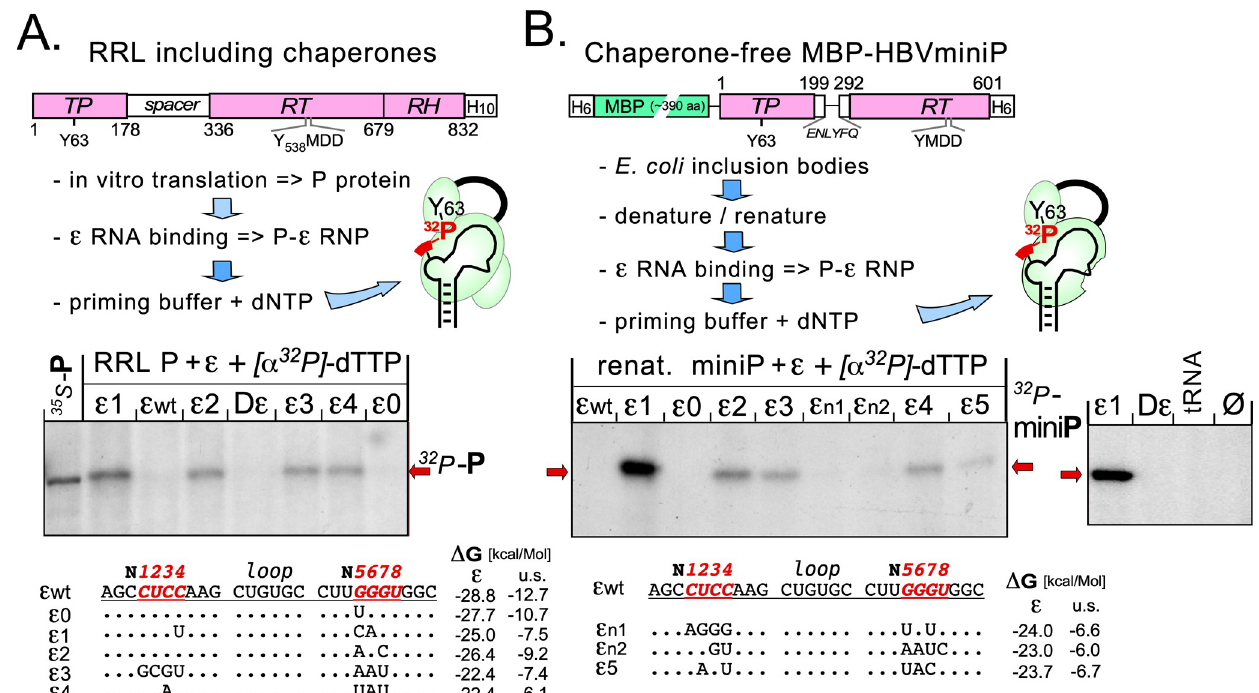
Fig 4. Select ε upper stem mutations enable in vitro priming. (A) RRL system. RRL programmed with full-length HBV P RNA in vitro translates P protein and provides chaperones. Next ε RNA is added for RNP formation. Finally priming conditions are established by adding priming buffer which includes bivalent metal ions such as Mg 2+ and/or Mn 2+ plus the desired α 32 P-dNTP (here dTTP). Successful priming results in 32 P labeled P protein, detected by SDS-PAGE followed by autoradiography. 35 S-labeled P protein produced by in vitro translation served as size marker. The most stably folded RNAs, ε wt and ε 0, as well as D ε gave virtually no signal while ε 1 to ε 4 did. (B) Chaperone-free HBV miniP system. The bacterial HBV miniP expression construct ending after residue I601 was designed by homology to a priming-active DHBV miniP construct [26]. The fusion protein was massively expressed as inclusion bodies and refolded as described for DHBV miniP and shown in S5 Fig. RNP formation and priming were induced as in RRL. Neither D ε nor tRNA nor a reaction without added RNA gave a comparable signal to ε 1 RNA ( right panel ).